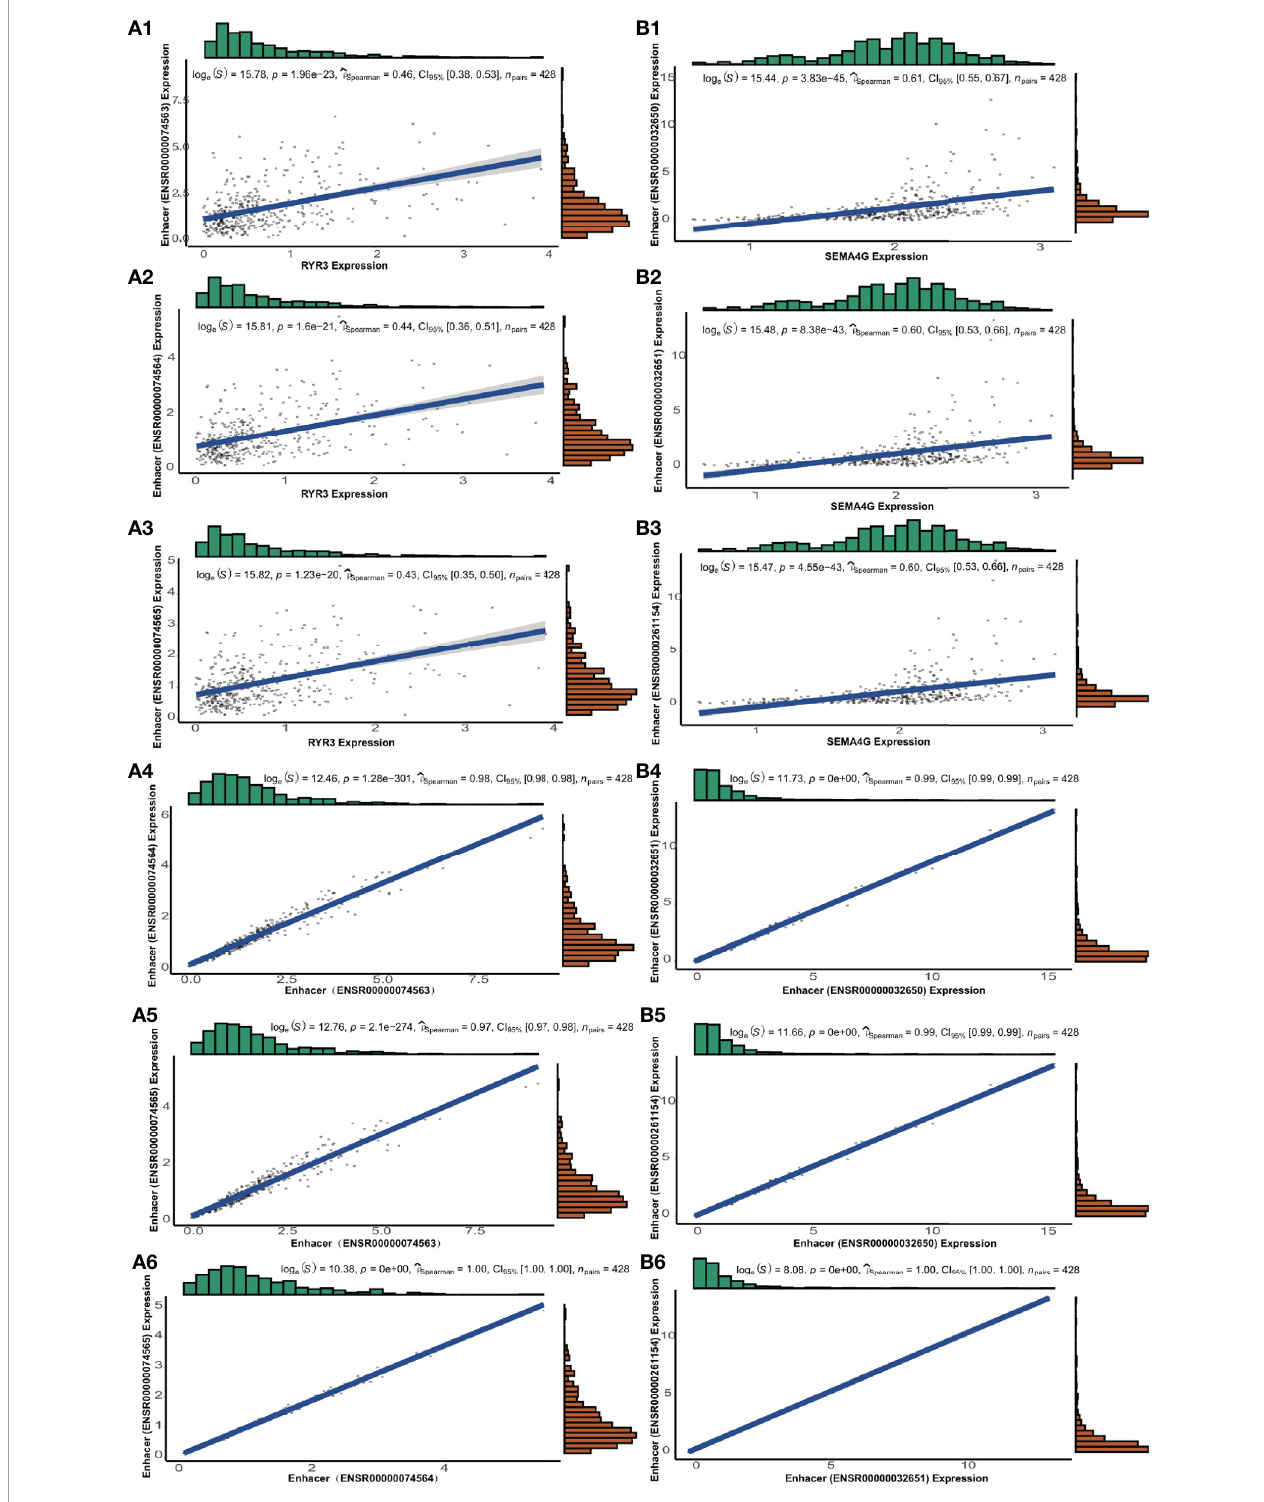
FIGURE 5 | The genes of RYR3 and SEMA4G and their regulative super-enhancers. (A1-A3) The correlation between the expression and its regulative eRNAs of RYR3. (A4-A6) The correlation among regulative eRNAs of RYR3. (B1-B3) The correlation between the expression and its regulative eRNAs of SEMA4G. (B4-B6) The correlation among regulative eRNAs of